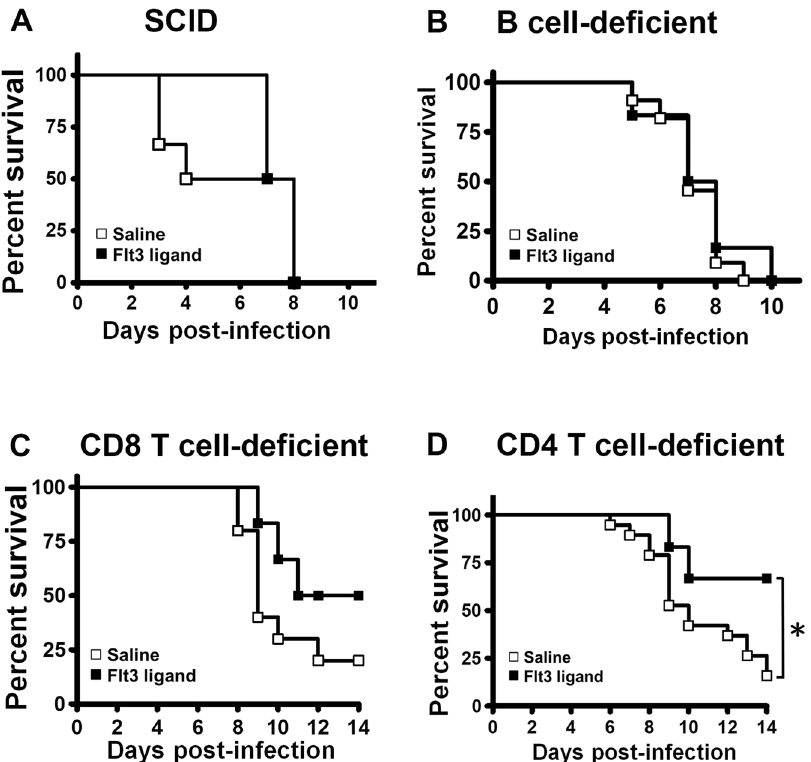
Figure 3. The effects of Flt3 ligand pretreatment on the survival of lymphocyte-deficient mice infected with EV- A71. The survival rates of infected SCID mice ( A ), B cell-deficient mice ( B ), CD8 T cell-deficient mice ( C ), and CD4 T cell-deficient mice ( D ) pretreated with saline ( n = 6–19 per group) or Flt3 ligand ( n = 6 per group) are shown. * P <